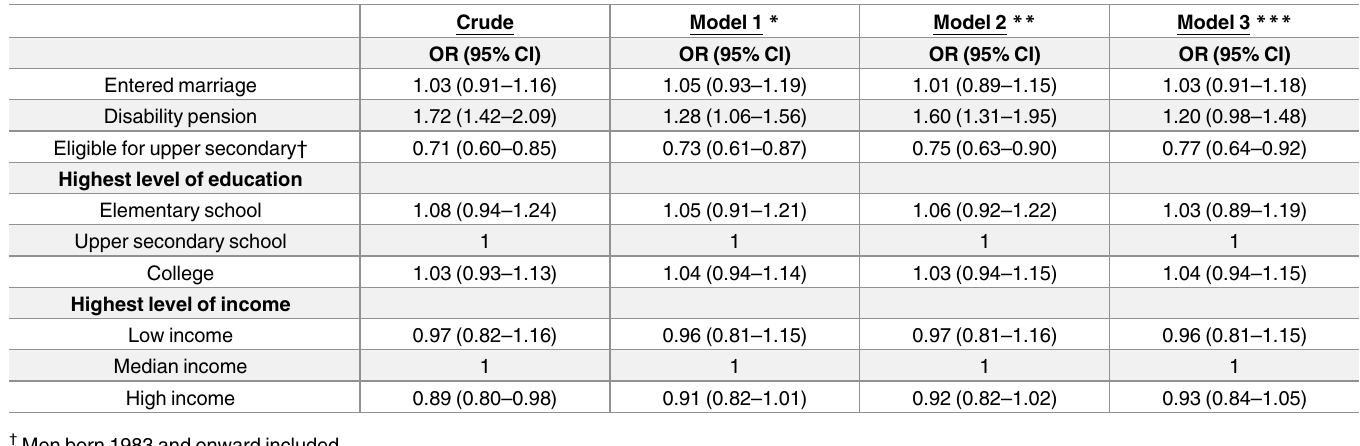
Table 3. Logistic regression models for the associations between distal hypospadias and socioeconomic